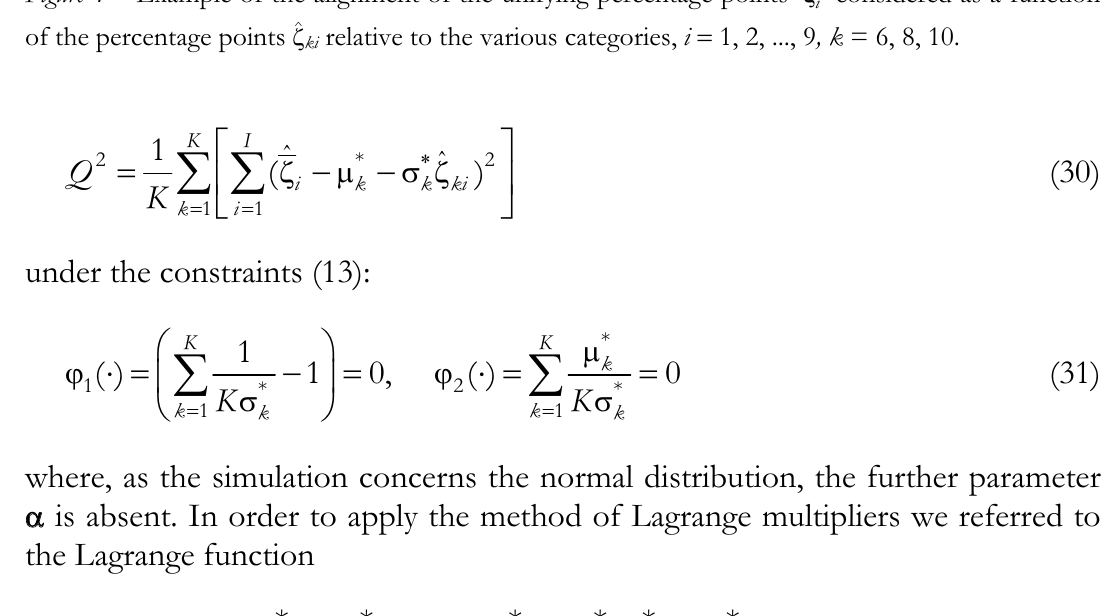
(cid:93) considered as a function i